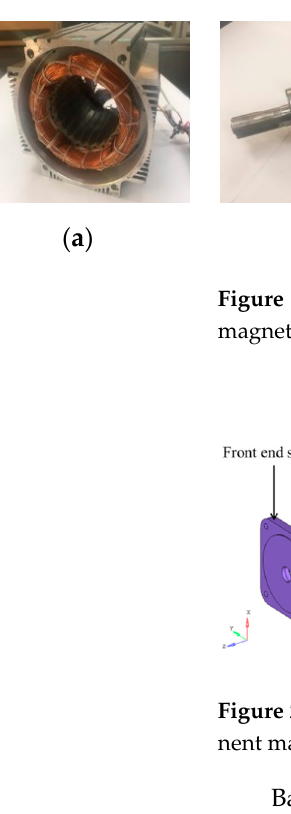
Figure 2. 3-D entire geometry of the BLDC motor including stator core, rotor, rotor housing, perma- nent magnets, stator housing, fin, coil, and other various components.